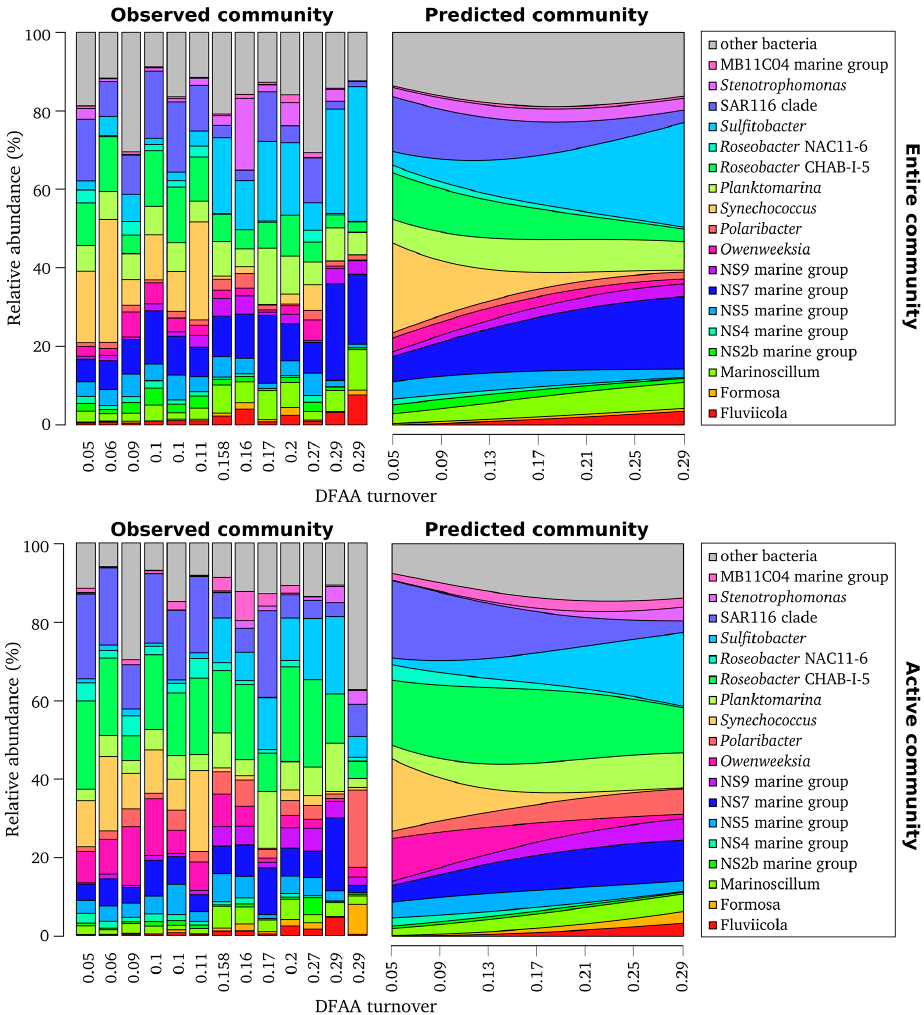
Figure 5. Observed and predicted composition of entire and active bacterioplankton communities in the North Sea. The measured dissolved free amino acids (DFAA) turnover rate is shown for the observed community. The stations are ordered from low to high DFAA turnover as follows: 14, 7, 16, 12, 13, 15, 11, 8, 1, 10, 6, 3, and 2. Compositional predictions were calculated based on observed community data using a multinomial log-linear model with DFAA turnover rates as sole explanatory variable. The range of the DFAA gradient used is equivalent to the DFAA turnover rates